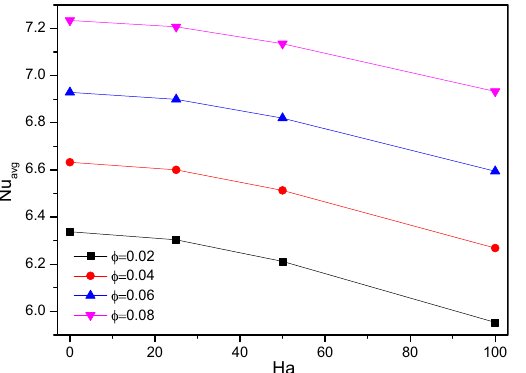
Figure 13. Variations of Nu avg with Ha for diverse φ when Ra = 10 6 , ω = 0 , Da = 0.01 , N = 4 , r = 0.1 and ε = 0.2 .